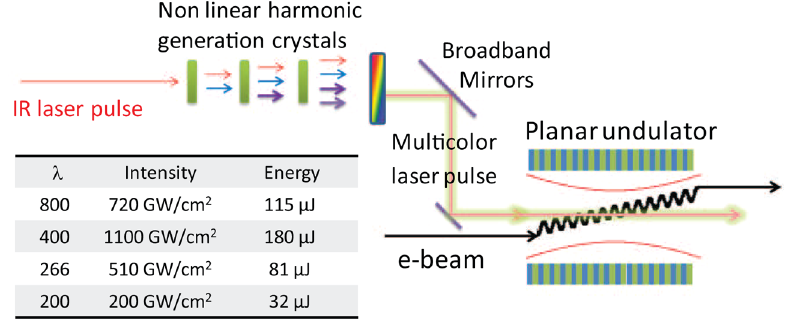
FIG. 6. Scheme of a nearly ideal harmonic prebuncher which uses nonlinear conversion crystals to generate up to the fourth harmonic of an infrared laser